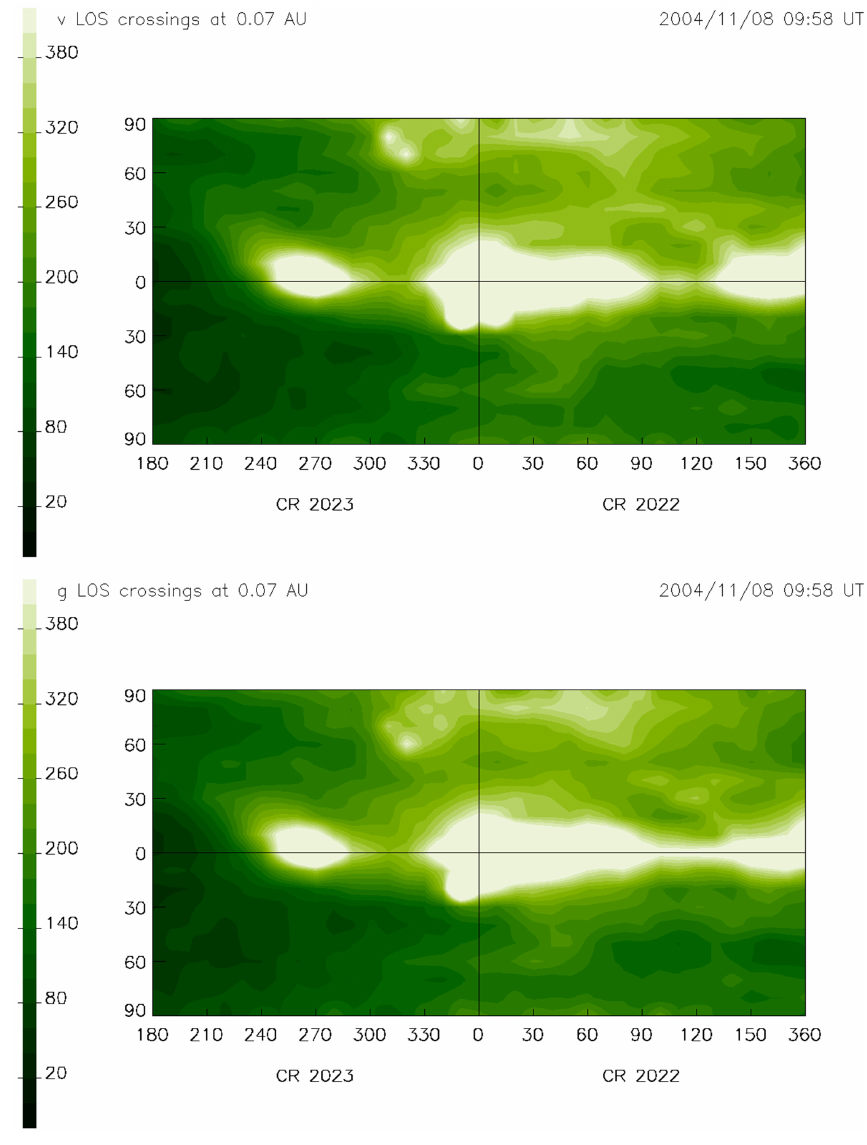
Fig. 5. The summed Ooty IPS LOS crossings from velocity (top) and g -level (bottom) observations (in each 10 ◦ × 10 ◦ reconstructed bin) mapped back to the source surface (as per Bisi et al., 2009a). Those portions of these maps having the largest number of LOS crossings have the highest confidence level. The source-surface LOS crossings for each time-reconstructed Carrington map are normalised per day crossings and for the Gaussian temporal and spatial filters. Approximately 32.5 days of observations are used to make the Carrington plots shown here. In the tomography at these Ooty resolutions, the standard deviations of the Gaussian filters are respectively 0.325day and 7°; see Jackson et al. (2003) and Jackson et al. (2008) for further